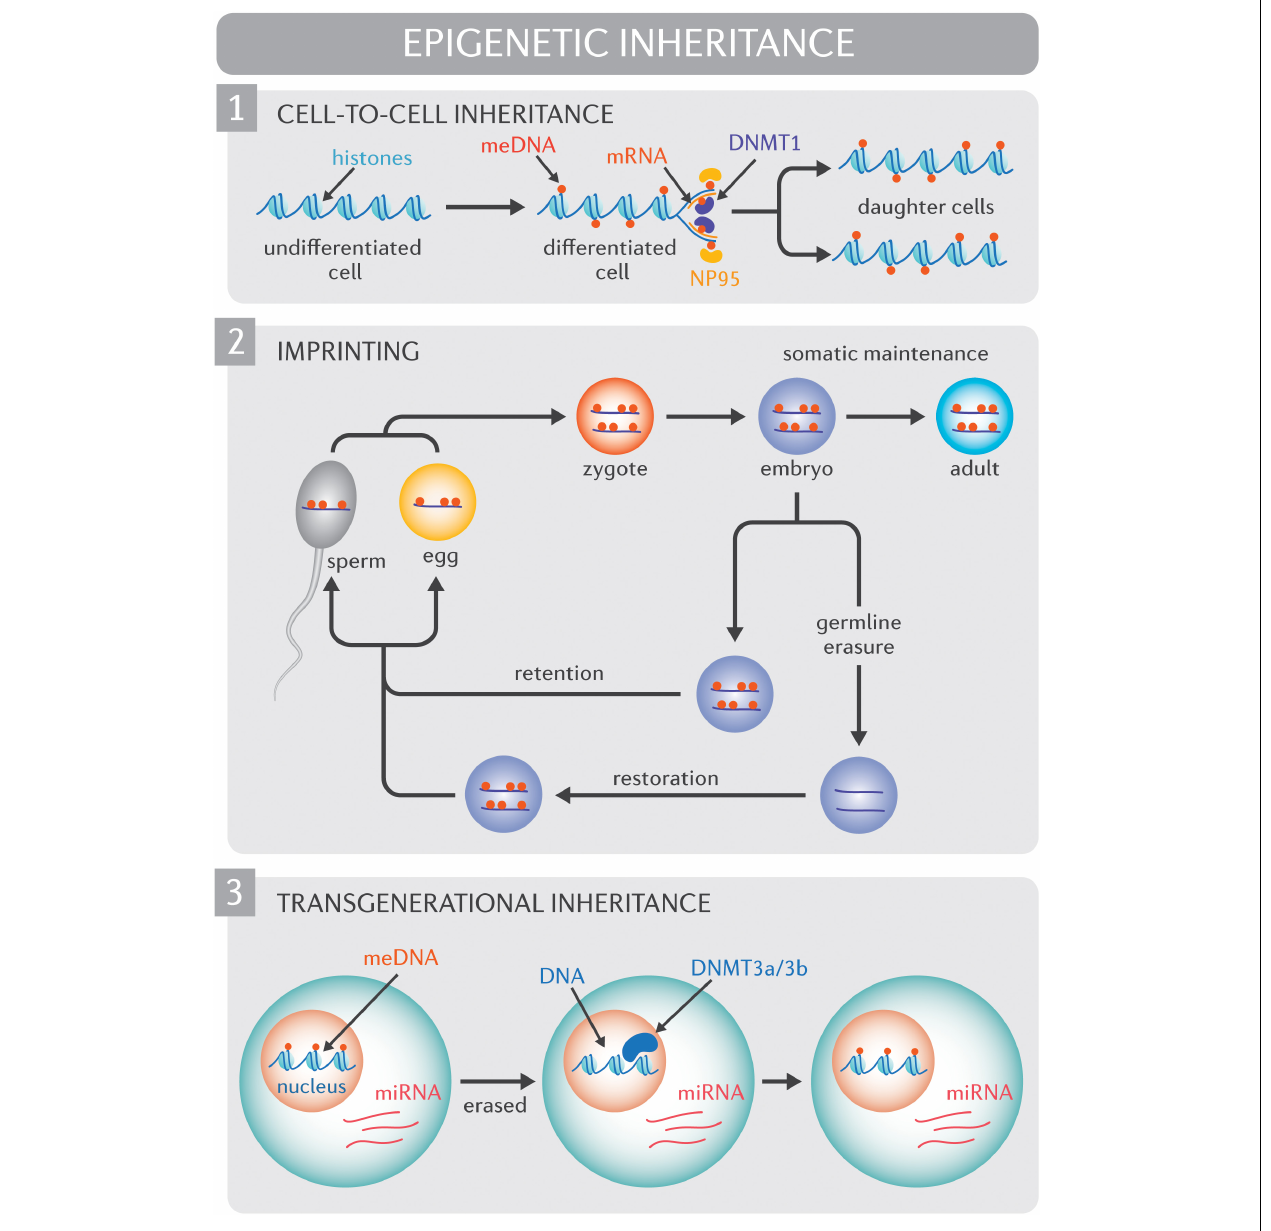
FIGURE 1 | Molecular mechanisms of epigenetic inheritance. (1) Cell-to-cell inheritance of epigenetic modifications. At the outset of semi-conservative DNA replication, cytosine methylation marks (red circles) are only present on the original (“mother”) strands of DNA. NP95 (yellow ovals) binds methylated cytosines, and recruits DNMT1 (purple oval) which is responsible for the de novo methylation of DNA on the complementary daughter DNA strands. (2) Genomic imprinting. Epigenetic mechanisms drive genomic imprinting, a process by which select genes are expressed according to parental heritage. In the pre-implantation embryo, the widespread erasure of epigenomic marks spares imprinted genes (red circles, DNA methylation of imprinted genes) such that the epigenome of imprinted genes persists into adulthood. Extensive epigenetic reprograming of non-imprinted genes and select imprinted genes also occurs in the germ line. Epigenetic modifications that are not retained through the reprograming process are subsequently restored in a sex-specific manner. (3) Transgenerational inheritance. Non-imprinted genes undergo vast, albeit incomplete, epigenetic erasure prior to implantation. During this process, much of the epigenome, including DNA methylation marks (meDNA) are “erased”. It has been proposed that small and long non-coding RNA species (including micro RNAs [miRNA]) recruit methylating enzyme complexes such as DNMT3a/3b to restore epigenome to its original